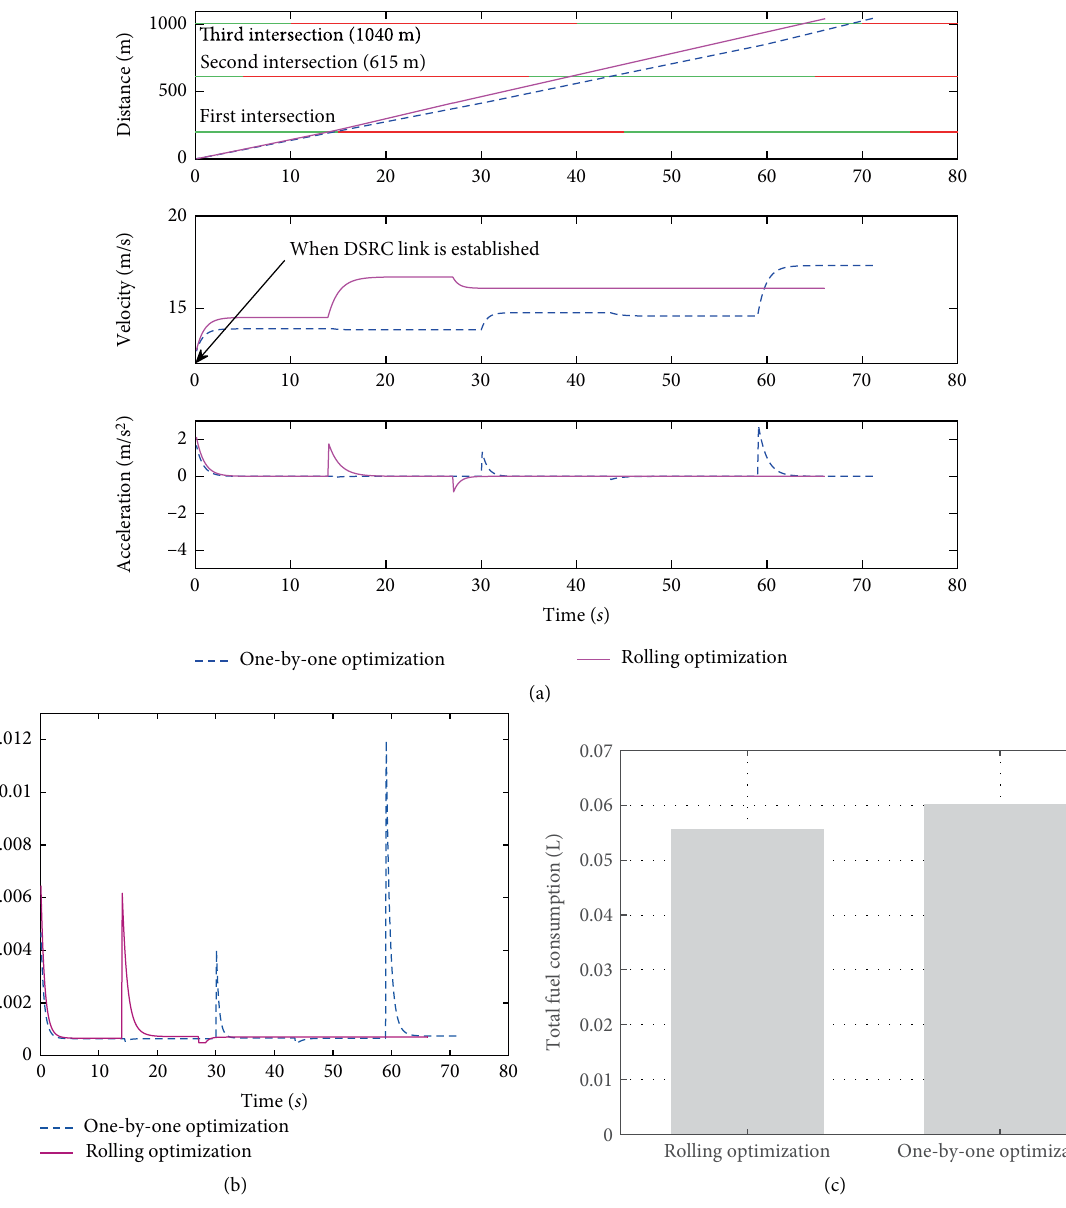
Figure 7: Comparisons between the rolling optimization and the one-by-one optimization. (a) Vehicle trajectories; (b) instantaneous fuel consumption; (c) total fuel